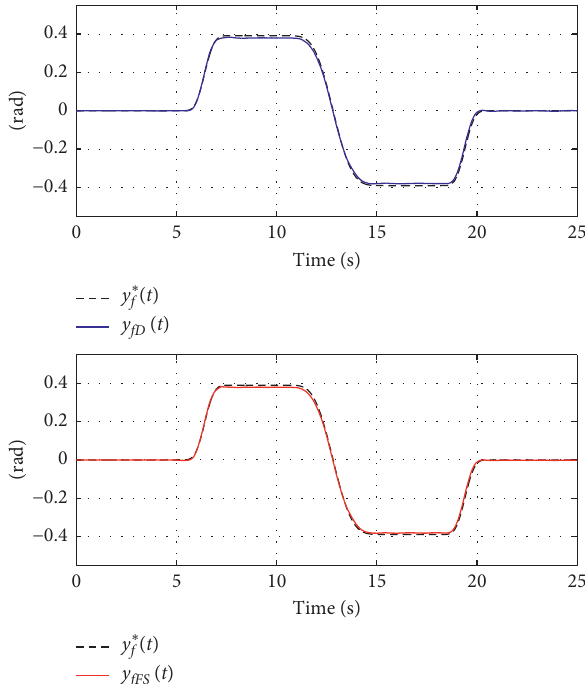
Figure 17: Flat output trajectory